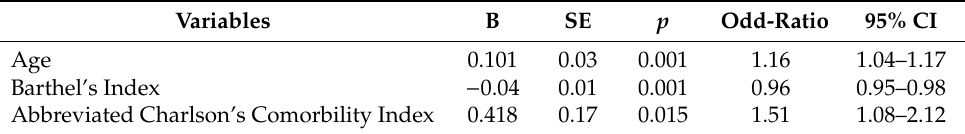
Table 4. Binary Logistic Regression to predict sarcopenia vs.